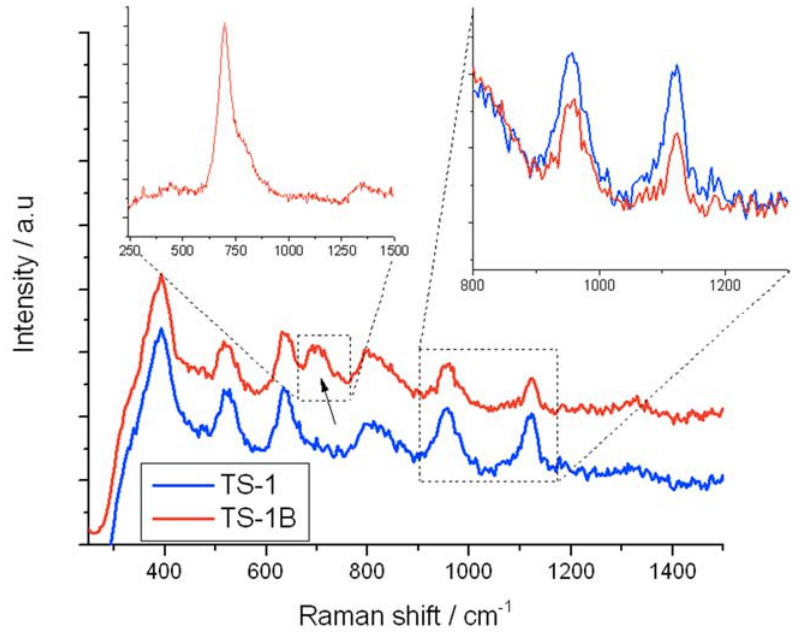
Figure 8. UV-Raman (325 nm) spectra of (blue/bottom) TS-1 and (red/top) TS-1B. The right inset shows the relative intensities of the 960 and 1125 cm − 1 bands, whilst the left inset shows the intensity of the 695 cm − 1 band when TS-1B is excited with a 266 nm